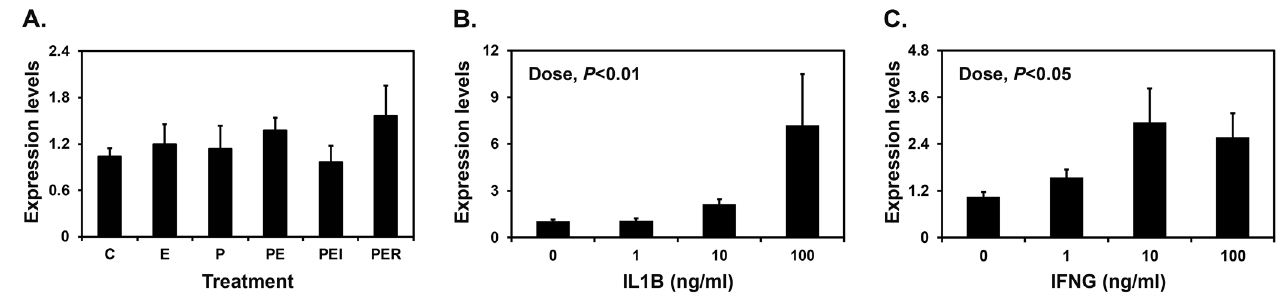
Figure 4. Effects of steroid hormones (A), IL1B (B), and IFNG (C) on the expression of serum amyloid A3 ( SAA3 ) in endometrial explant cultures. Endometrial explants from gilts on day 12 of the estrous cycle were cultured (A) with steroid hormones [control (C), E E +P +ICI (ICI, an estrogen receptor antagonist) (PEI), or E 2 4 IL1B (0, 1, 10, and 100 ng/mL) in the presence of E IFNG (0, 1, 10, and 100 ng/mL) in the presence of E analyses is relative to that for SAA3 mRNA in the control group of endometrial explants after normalization of the transcript amounts to RPL7 , UBB , and TBP mRNAs. Data are presented as mean with standard error. For each treatment, experiments were performed with endometria from eight gilts. These treatments were performed in triplicate using tissues obtained from each of three gilts. RT-PCR, reverse transcription-polymer- ase chain reaction; RPL7 , ribosomal protein L7; UBB , ubiquitin B; TBP , TATA binding protein.